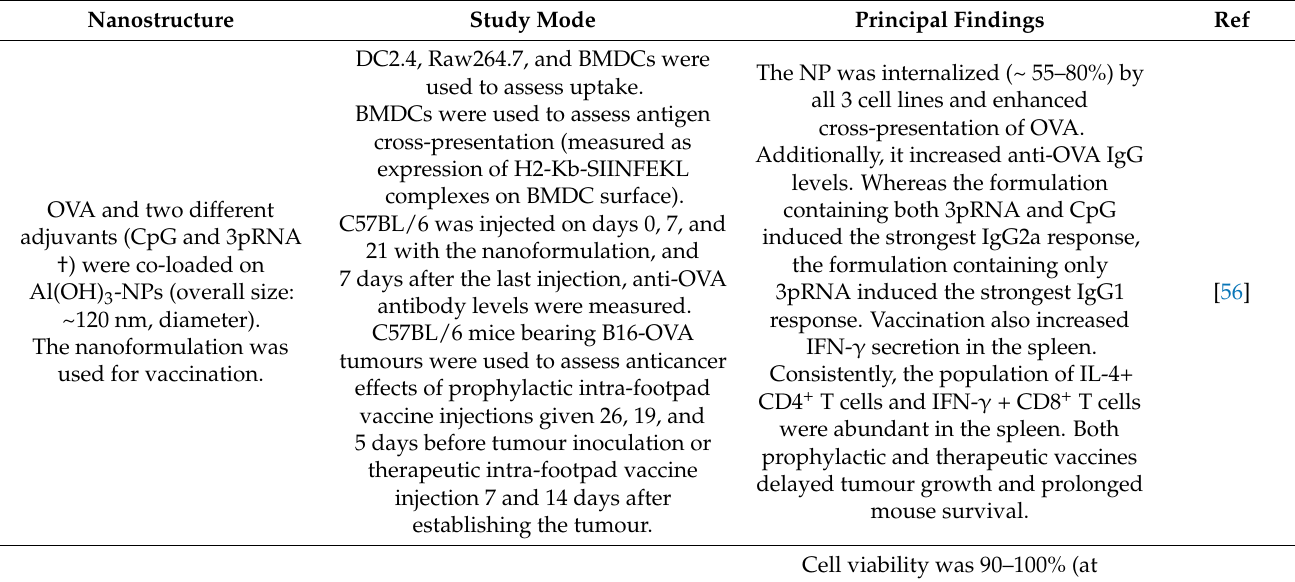
Table 2. Antitumour immune responses induced by